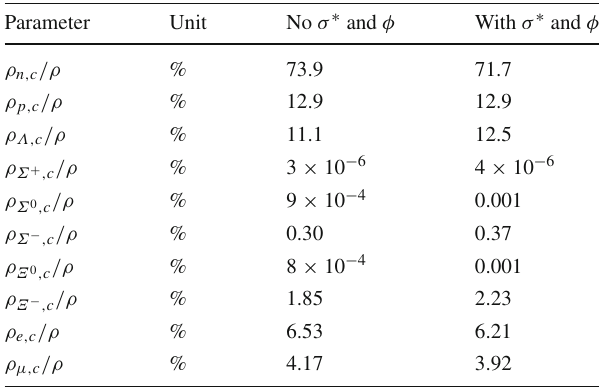
Table 2 The baryon center relative density of PNS PSR J0740+6620 calculated in this work. The mass of PNS PSR J0740+6620 is M = 2.14 M (cid:2) . ρ n , c /ρ , ρ p , c /ρ , ρ Λ, c /ρ , ρ Σ + , c /ρ , ρ Σ 0 , c /ρ , ρ Σ − , c /ρ , ρ Ξ 0 , c /ρ , ρ Ξ − , /ρ , ρ /ρ and ρ μ, /ρ are center relative density of n, p, Λ , Σ + e , c c c